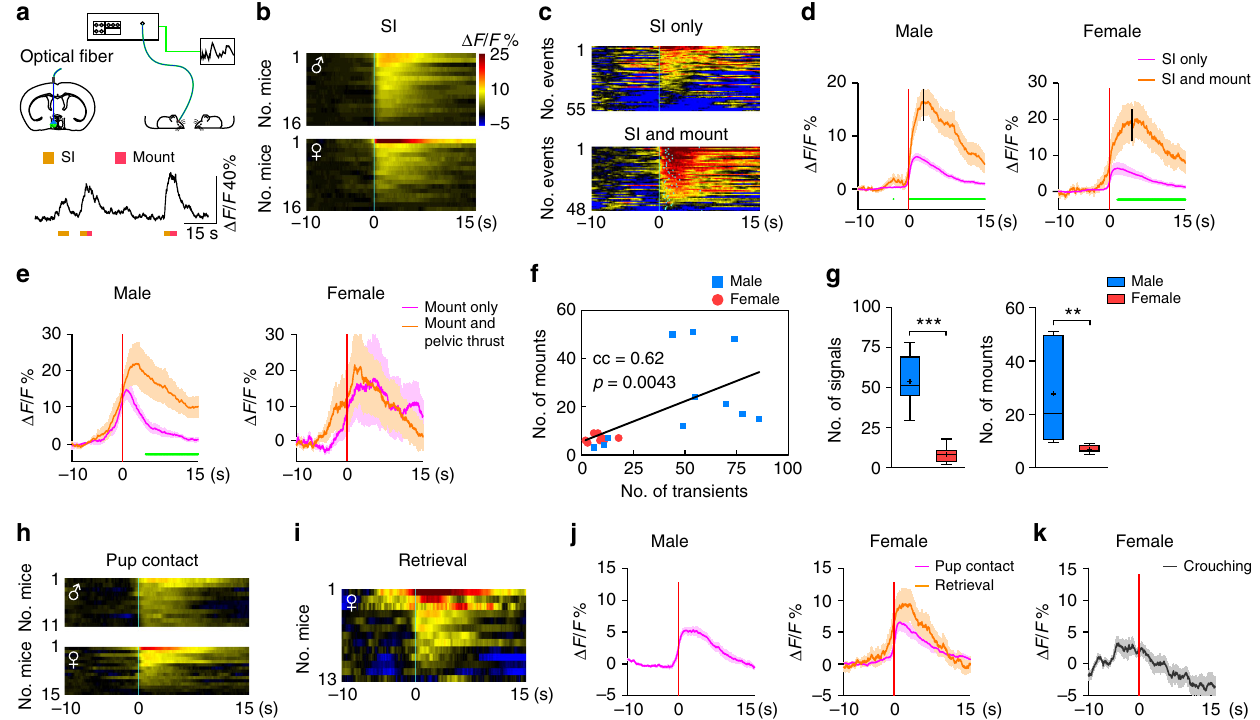
Fig. 1 mPOA neural dynamics during social behaviors. a Schematics of the fi ber photometry experiment. Fluorescent signals were recorded using an integrated setup. At the bottom, example traces of Δ F / F signals with behavioral annotations underneath. b Heat map representation of Δ F / F signals around social investigations (SI) averaged at the animal level with time “ 0 ” aligned to the onset of the behavior. Scale shown on the right applies to all heat maps in this fi gure. c Example heat map representations of Δ F / F signals around events of SI alone (top) or those that were followed by mount (bottom). Light blue lines in the bottom panel denote the onset of mount for each event. d , e Quanti fi cation of Δ F / F signals associated with SI alone or those followed by mount in males (left) and females (right) in d , and mount followed by pelvic thrust or not in males (left) and females (right) in e . Lines indicate mean values and the shaded area standard error of mean (s.e.m.). Vertical black bars in d denote when mount behaviors were initiated on average. Green dots underneath indicate a signi fi cant difference between the two lines at the corresponding time point by unpaired t test with a false discovery rate of 0.05. d SI, N = 16 males and 16 females; Mount, N = 13 males and 10 females; e N = 6 males and 4 females. f Signi fi cant correlation between total number of Ca 2+ transients and the total number of mount between the fi rst and last mounting behavior in a trial by Pearson ’ s correlation. N = 11 trials for males and 8 trials for females. g Comparison of numbers of Ca 2+ transients (left) and numbers of mount (right) in f between males and females at the animal level. N = 8 males and 8 females. Unpaired t test. * p < 0.05, ** p < 0.01. h , i Heat map representations of Δ F / F signals around pup contacts ( h ) and pup retrieval ( i ) at the animal level with time “ 0 ” aligned to the onset of the behavior. j , k Quanti fi cation of Δ F / F signals associated with pup contact and pup retrieval in males (left) and females (right) in j and crouching behavior in females in